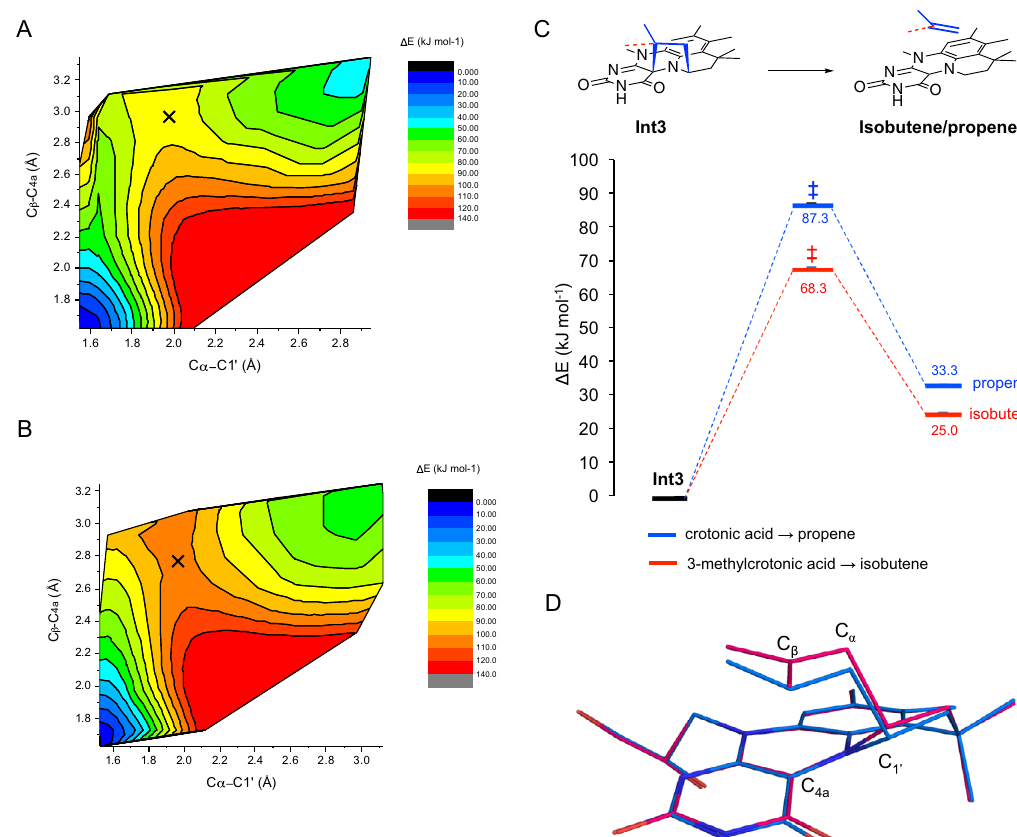
Fig. 6 DFT calculations applied to the active site of Ta Fdc with 3-methylcrotonic and crotonic acid. Contour map of the potential energy (kJ mol − 1 ) landscape for 3-methylcrotonic acid ( A ) and crotonic acid ( B ) conversion to isobutene and propene, respectively, from Int3 by Ta FdcV, projected transition state is marked by X. C Zero-point energy corrected potential energy (kJ mol − 1 , Supplementary Tables 2 and 3) scheme for 3-methylcrotonic (red) and crotonic acid (blue) with the Int3 set as 0 and the projected approximate transition state denoted with double daggers. D overlay of the DFT optimized transition states between Int3 and product for 3-methylcrotonic (pink, C α – C 1 ’ and C β – C 4a bond lengths of 1.96 and 2.97 Å, respectively) and crotonic acid (blue, C α – C 1 ’ and C β – C 4a bond lengths of 1.95 and 2.77 Å, respectively). Source data underlying A – C are provided as a Source Data fi